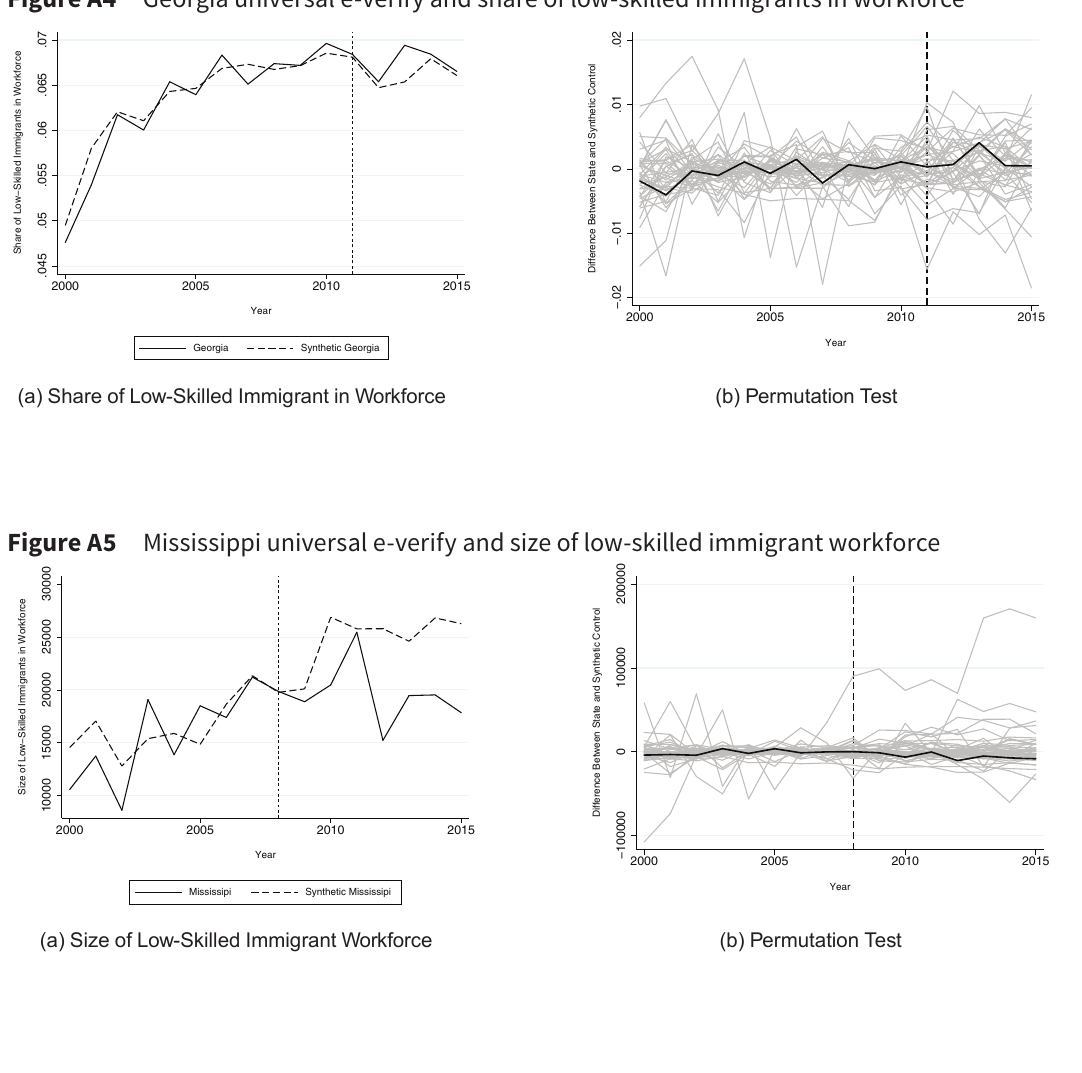
Figure A6 Mississippi universal e-verify and share of low-skilled immigrants in